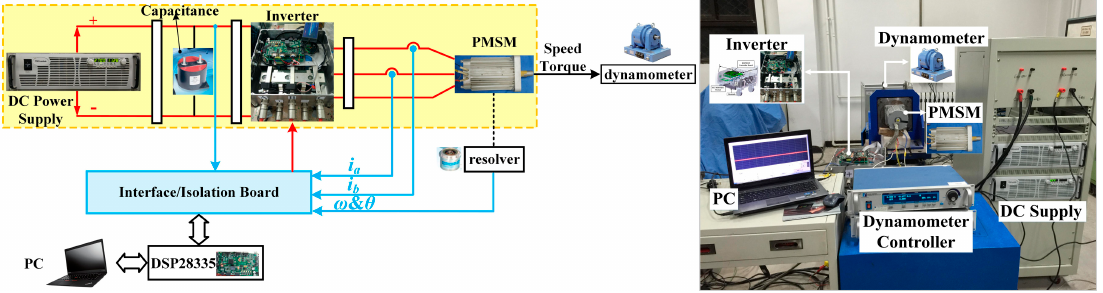
Figure 10. Experimental setup of the PMSM drive system.